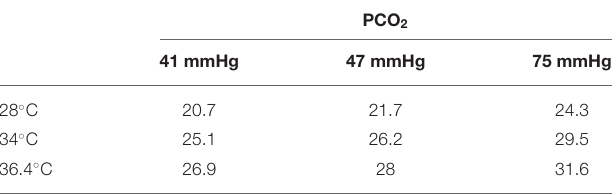
TABLE 3 | A model for P50 in an avalanche burial